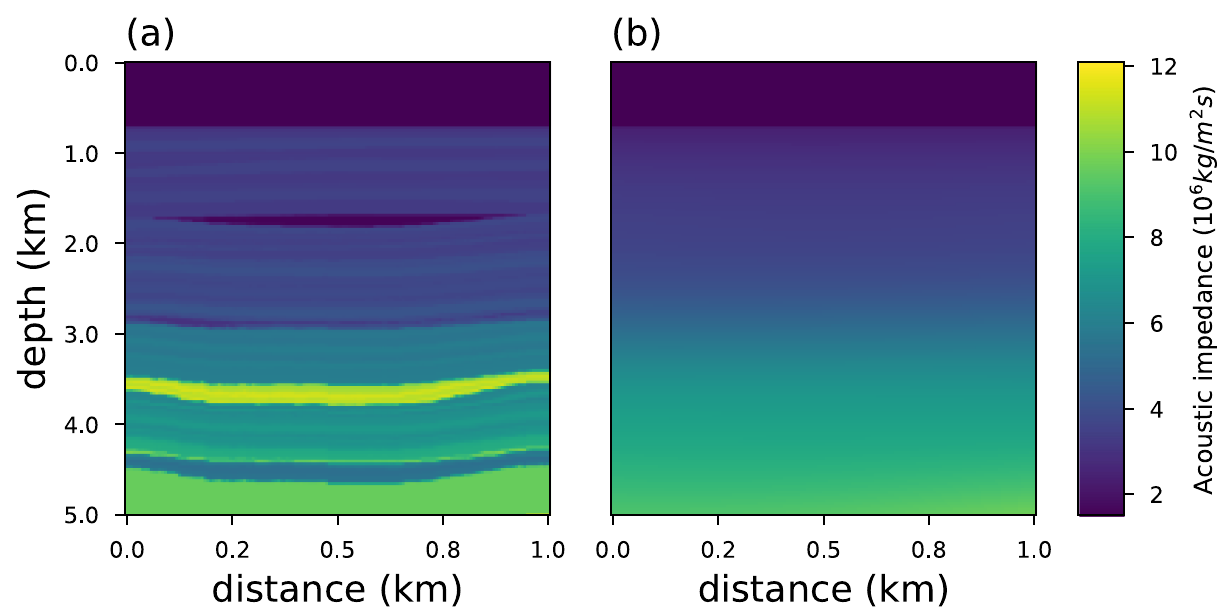
Fig 10. The geophysical model employed to illustrate the inversion methodology. In (a) the synthetic acoustic impedance model called Marmousi2. In (b) we show the initial model employed in the inversion methodology.